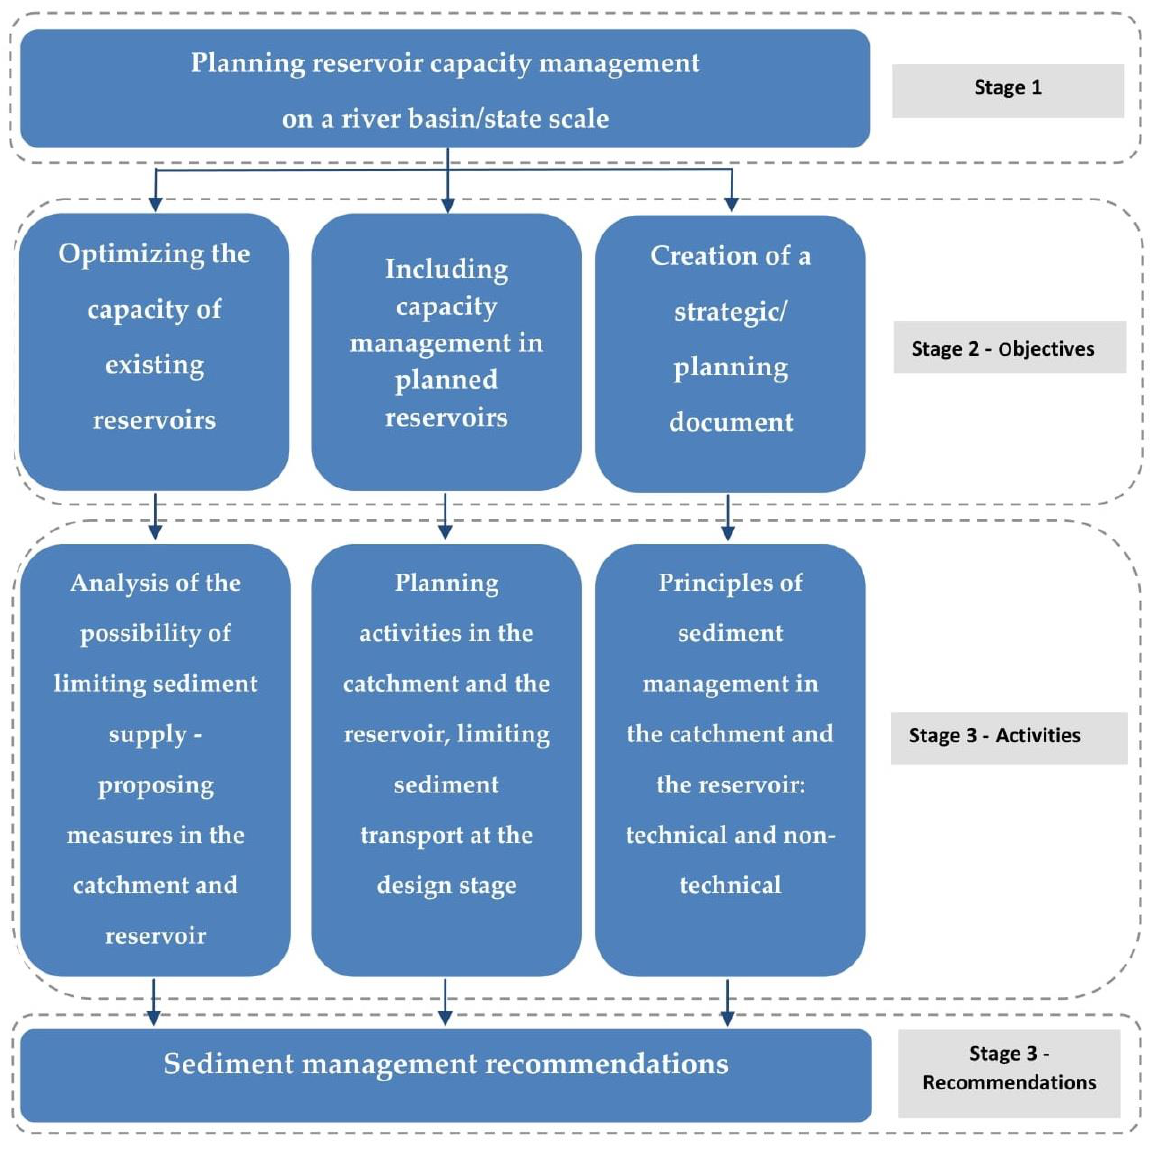
Figure 8. Conceptual model of capacity management of retention reservoirs.